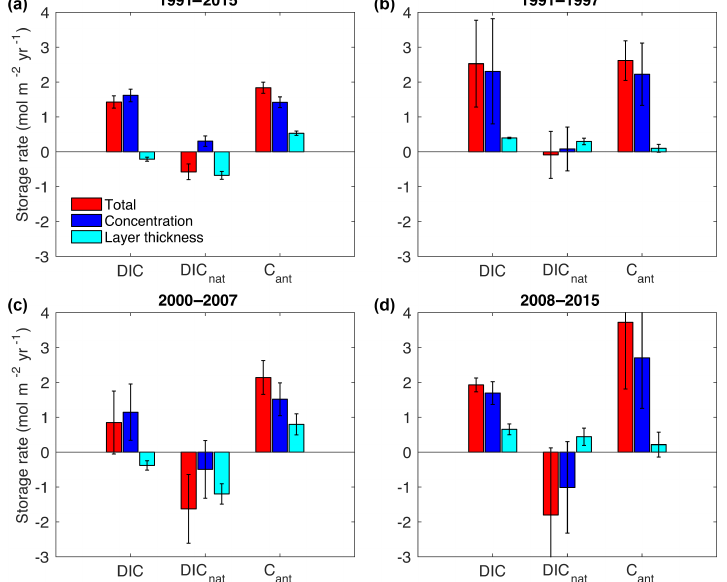
Figure 9. Decomposition of the total storage rates (red bars) into the concentration-driven storage rate (blue bars) and the layer-thickness- driven storage rate (cyan bars) for DIC, C ant and DIC nat from (a) 1991–2015, (b) 1991–1997, (c) 2000–2007 and (d) 2008–2015. The error bars represent the error of the linear regression